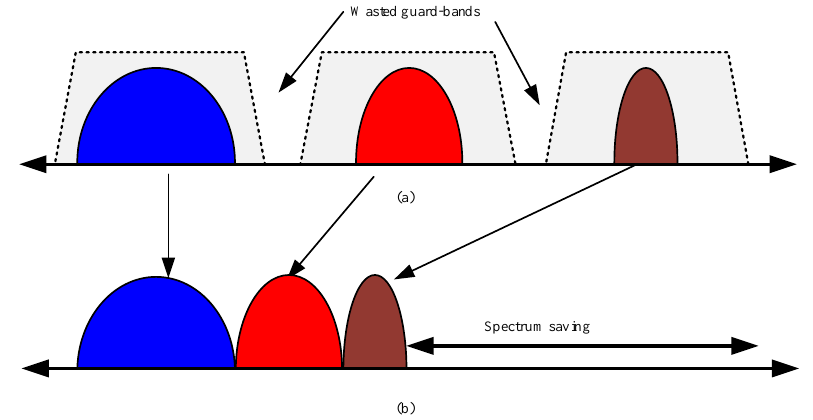
Figure 2. Optical spectrum for ( a ) DWDM and ( b ) super-channel